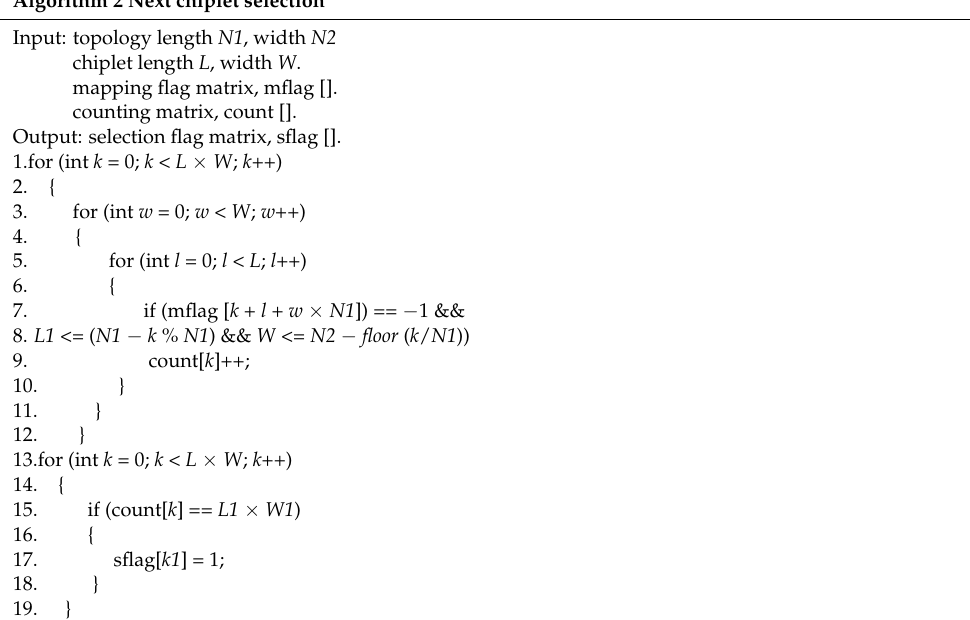
Algorithm 2 Next chiplet